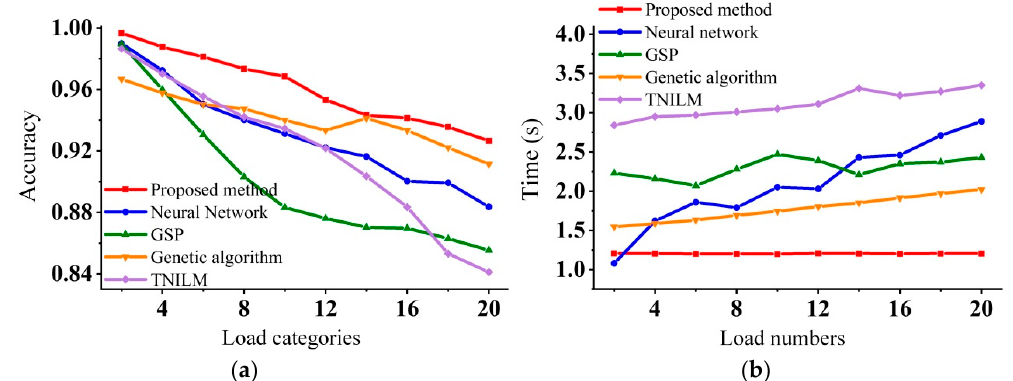
Figure 16. Performance comparison of algorithms. ( a ) Load identification accuracy comparison of di ff erent algorithm under di ff erent category numbers; ( b ) Operation e ffi ciency comparison of di ff erent algorithm under di ff erent load